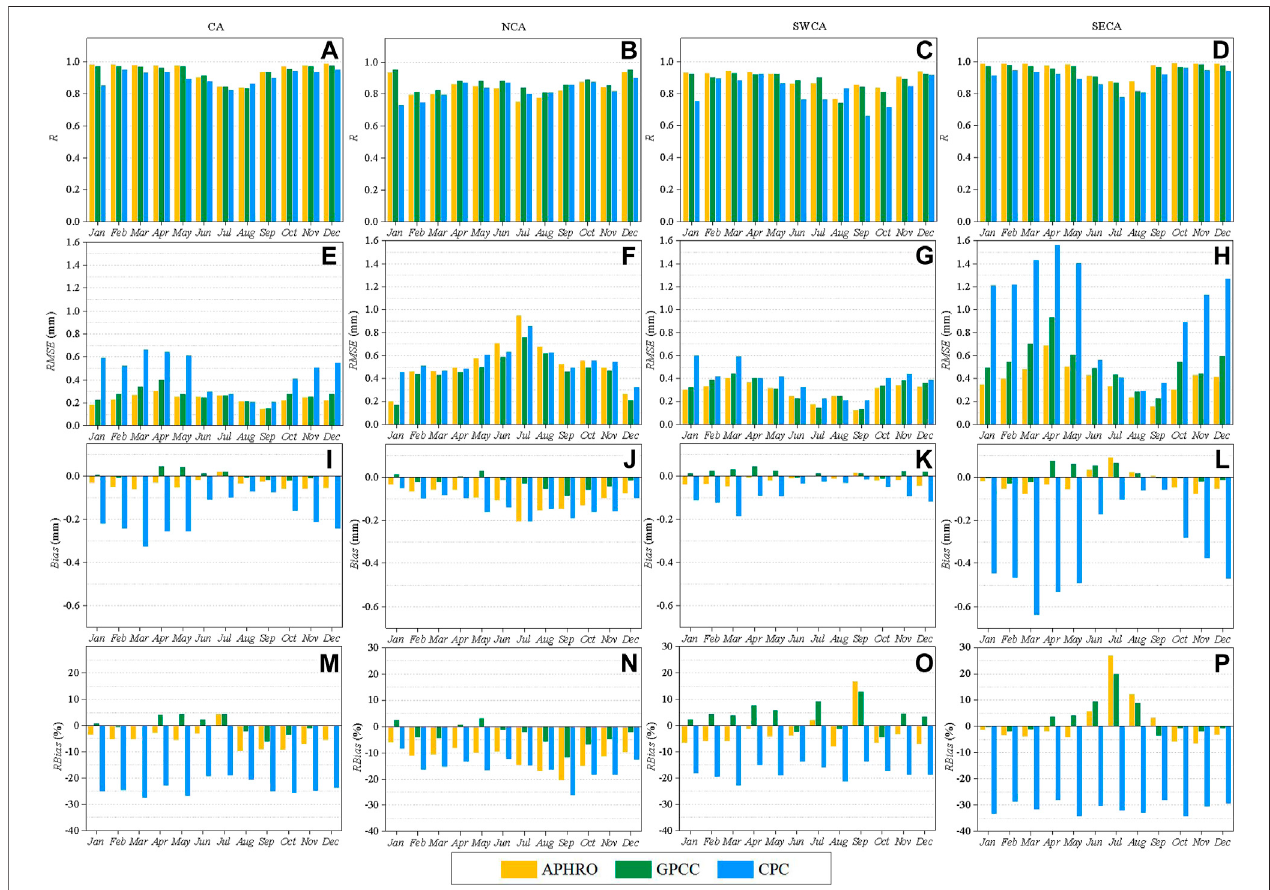
FIGURE 7 | The statistics metrics of average precipitation comparing the OBS with APHRODITE (yellow), GPCC (green) and CPC (blue) at monthly scale for the different regions. (A) , (E) , (I) , and (M) for CA; (B) , (F) , (J) , and (N) for NCA; (C) , (G) , (K) , and (O) for SWCA; (D) , (H) , (L) , and (P) for SECA.